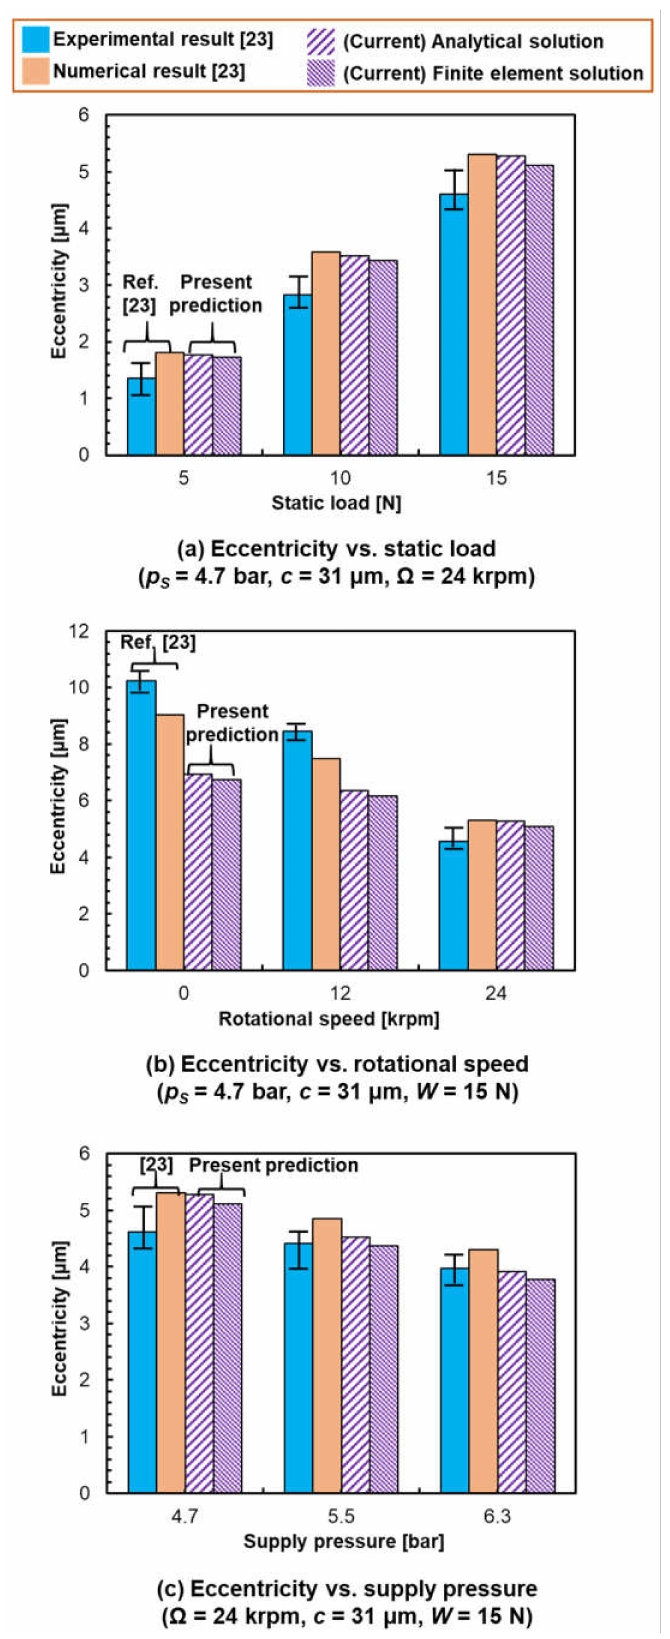
Figure 9. Predictions from current models (analytical and FE) compared to experimental results and predictions reported in [23]. ( a ) Journal eccentricity ( e ) vs. static load ( W ); ( b ) eccentricity ( e ) vs. shaft speed ( Ω ); ( c ) eccentricity ( e ) vs. supply pressure ( p S